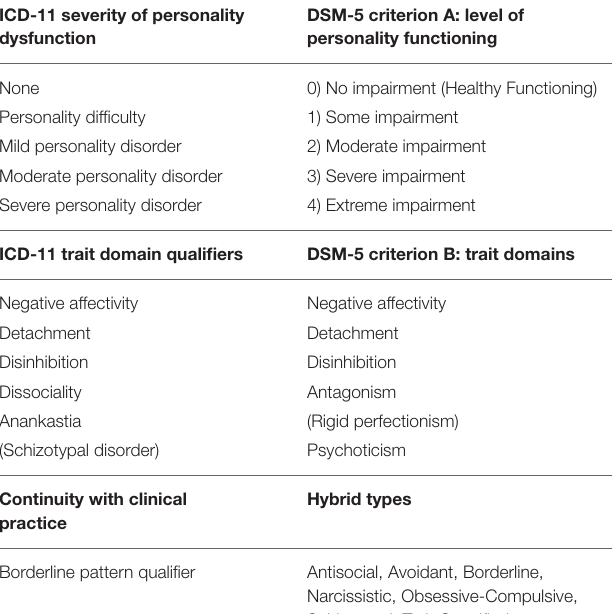
TABLE 1 | Alignment between ICD-11 and DSM-5 alternative model for personality disorders